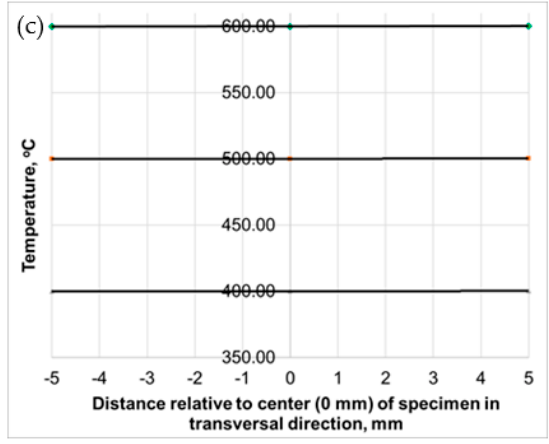
Figure 2. Temperature distribution along the longitudinal and transversal directions of a specimen: ( a ) measured temperature distribution along the longitudinal direction, ( b ) comparison of temperature difference (Tmax-Tmin) at ± 3 mm distance relative to the center along the longitudinal direction, and ( c ) measured temperature distribution along the transversal.